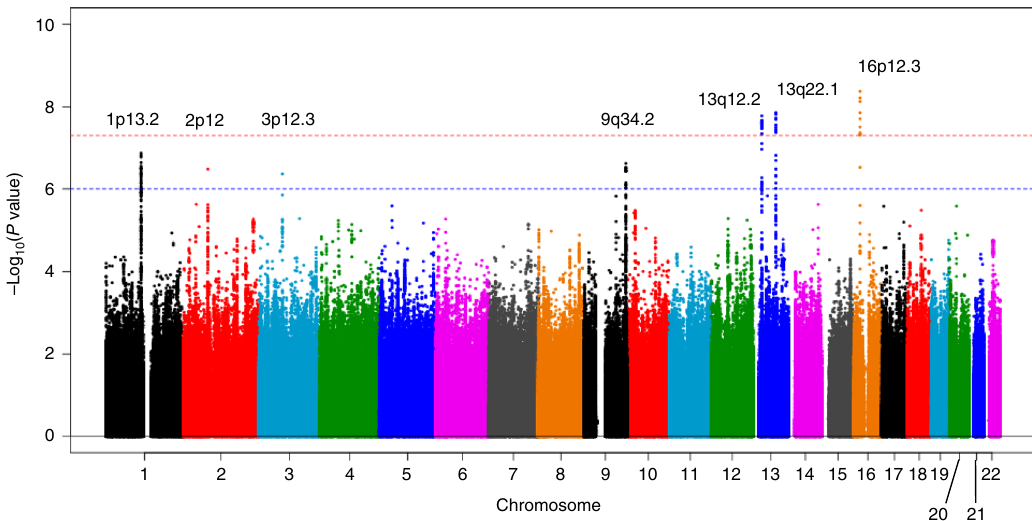
Fig. 1 Manhattan plot for the meta-analysis. The horizontal red line represents the genome-wide signi fi cance threshold ( α = 5 × 10 − 8 ). The horizontal blue line represents the suggestive signi fi cance threshold ( α = 10 − 6